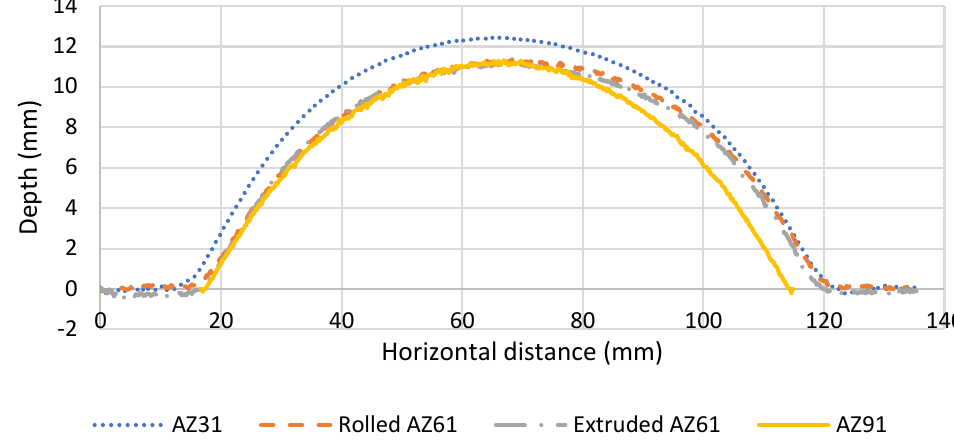
Figure 20. Comparison of forming shapes of AZ31, AZ61, and AZ91.